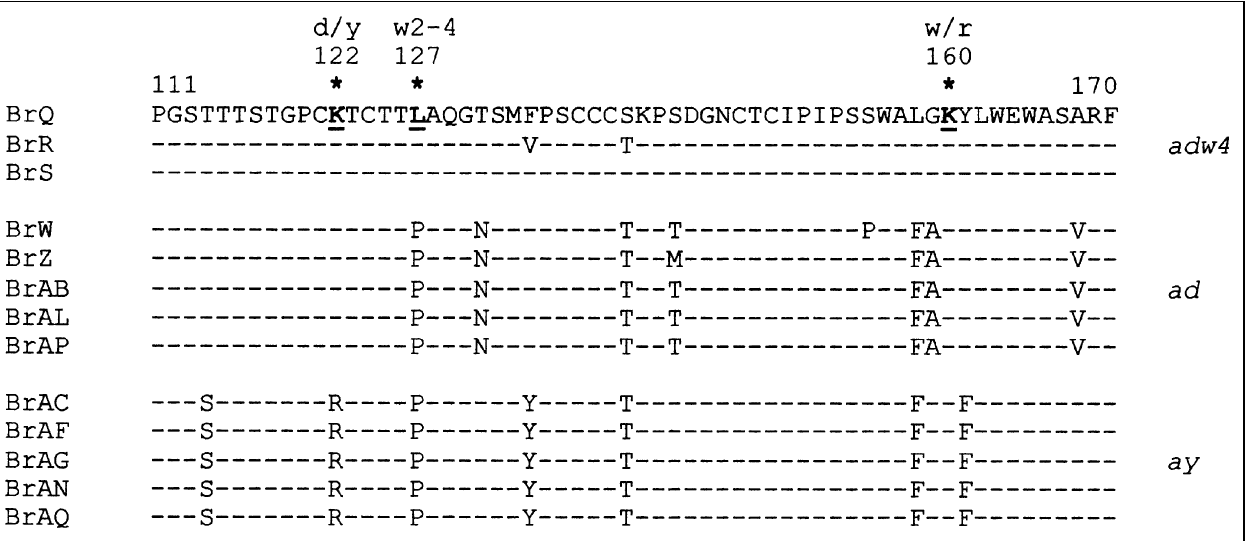
Figure 2 - Amino acid sequences deduced from partial nucleotide sequence of S genes of 13 HBV strains from the Amazon region. Asterisks indicate the positions of the antigenic determinants and subdeterminants. The HBsAg subtype of the strains was deduced from the substitutions of codons 122 and 160, which determine d/y and w/r , respectively. Antigenic subdeterminant w4 is defined by a Leu at codon 127 (9). Note that all strains other than adw4 possess a Pro defining the subdeterminant w2 at position